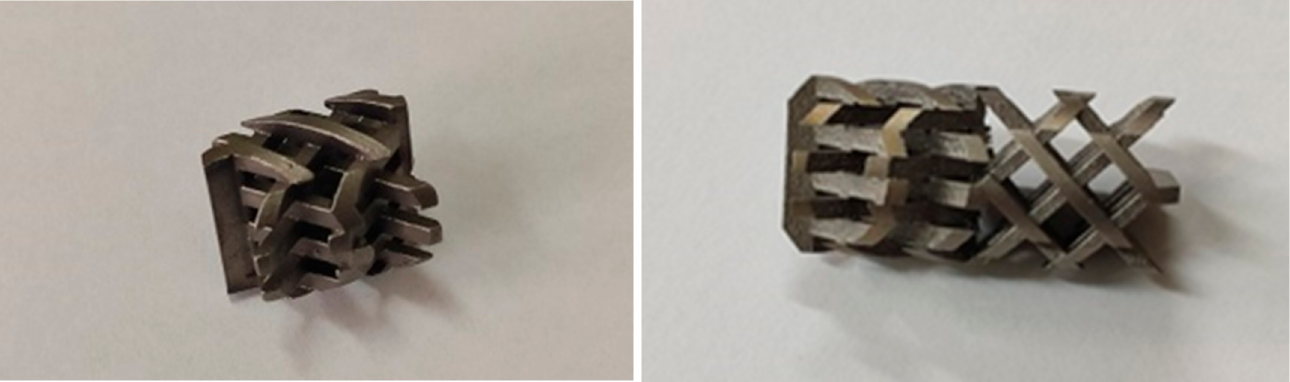
Figure 4. Photographs of the single ( left ) and double ( right ) static mixers.